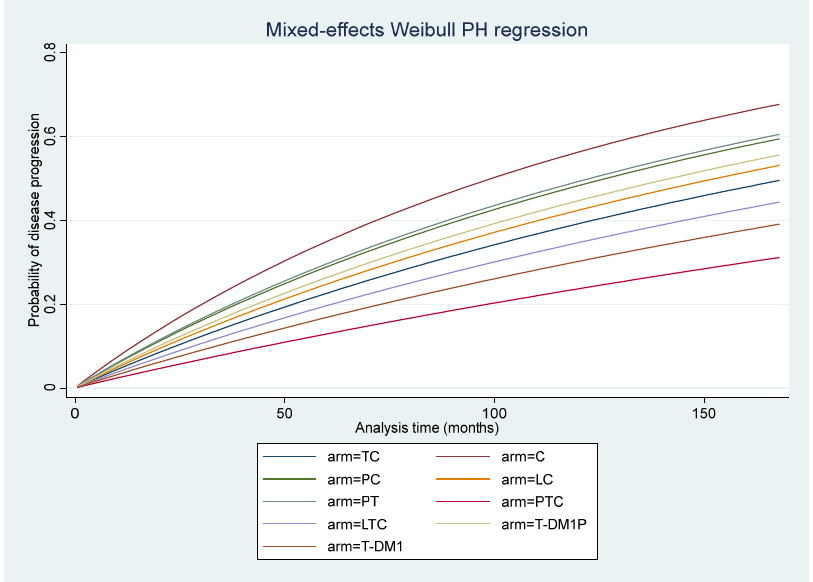
Figure 4. Mixed-effect parametric survival analysis of disease-free survival . C = chemotherapy; TC = Trastuzumab + chemotherapy; PC = Pertuzumab + chemotherapy; LC = Lapatinib + chemotherapy; PTC = Pertuzumab + trastuzumab + chemotherapy; LTC = Lapatinib + trastuzumab +chemotherapy; PT = Pertuzumab + trastuzumab; T-DM1P = trastuzumab emtansine+ pertuzumab; T-DM1 = Trastuzumab emtansine. Table 3. Hazard ratios of disease-free survival of neoadjuvant regimens. Treatment Regimen